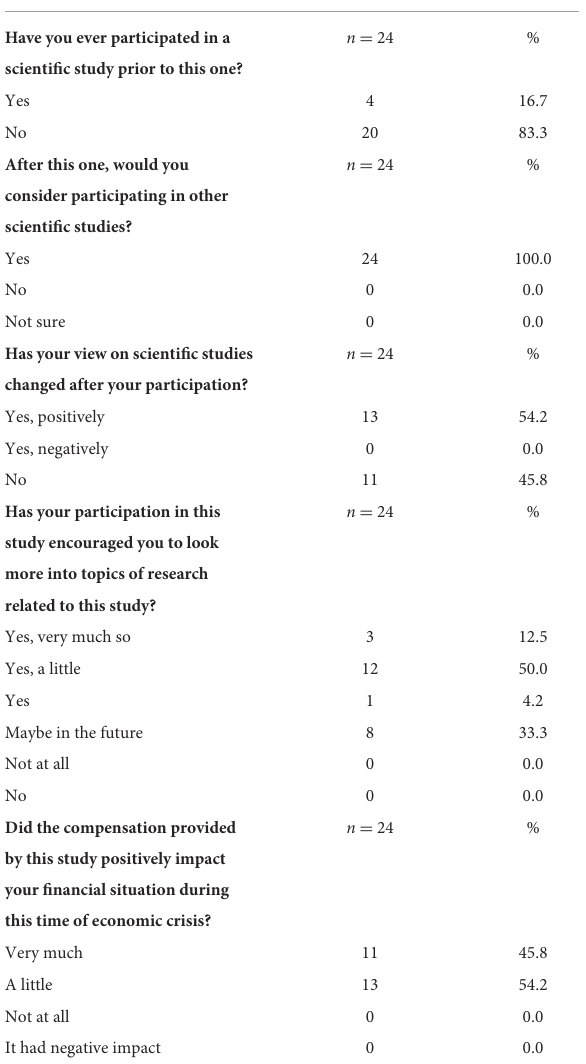
TABLE 3 Post-study